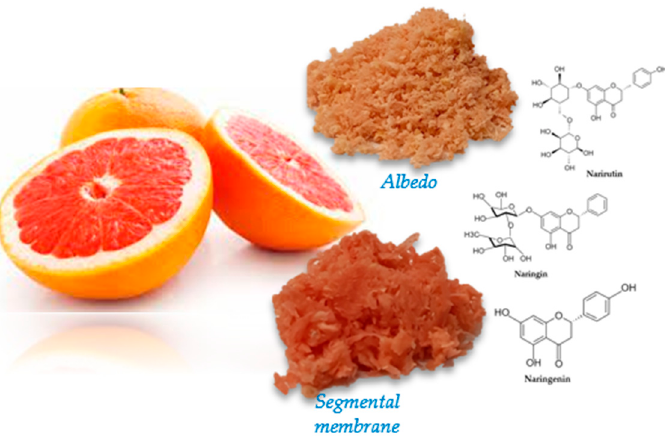
Figure 5. Fresh Albedo, and segmental membrane of Citrus × paradisi L. Standards of naringin, naringenin, and narirutin were obtained from Sigma Aldrich in Steinheim, Germany. Hydrochloric acid, sodium hydroxide, acetic acid, methanol, ac- etonitrile, Trolox, α -, β -, and γ -CDs were obtained from Sigma Aldrich in HH, DE. Ethanol (96%) was obtained from Vilniaus Degtine in Vilniaus, LT. GFL2004 was used to manu- facture filtered water (Burgwedelis, DE). The following reagents were also utilized: alu- minum chloride, hexamethylenetetramine, acetic acid, 2,20-azino-bis(3-ethylbenzothia- zoline-6-sulfonic acid) (ABTS), 2,4,6-Tris(2-pyridyl)-s-triazine (TPTZ), potassium persul- fate, ferrous sulfate heptahydrate, saline phosphate buffer, and hydrogen peroxide from Sigma Aldrich (Schnelldorf, DE); disodium hydrogen phosphate obtained from Merck (Darmstadt, DE); 2,2-diphenyl1-picrylhydrazyl radical (DPPH). 2.2. Methods 2.2.1. Extracts’ Preparation Control sample: a control batch was performed based on previous studies using a combined extraction method with 50 and 70% ethanol ( v/v ). The extraction process used in this study is shown in Figure 6 [45]. Figure 6. Combined extraction method schema. Test sample: The extracts were made under the same conditions. The 50% or 70% ethanol ( v / v ) was employed as the solvent (10 mL), and the additional substances (0.1 ± 0.105 g of α -, β -, γ -CDs) were added with plant material (1 ± 0.05 g). After centrifuging the materials for 10 min at 1789× g , the supernatant was discarded by decantation. The extracts